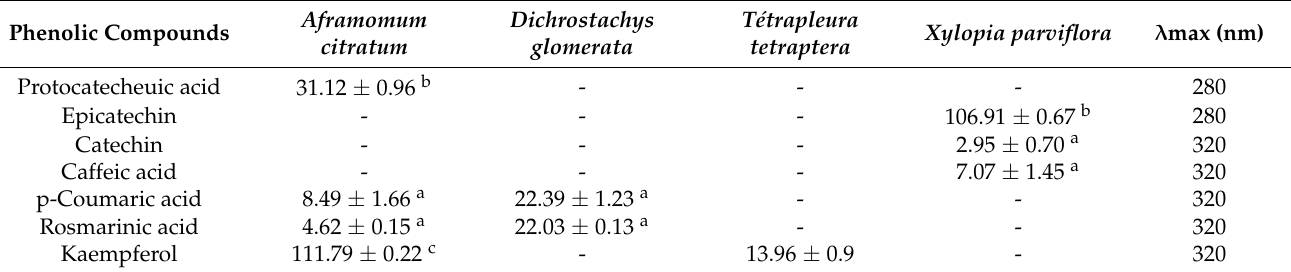
Table 2. Phenolic ( µ g/100 mg of extract) content in each extract through HPLC-PDA